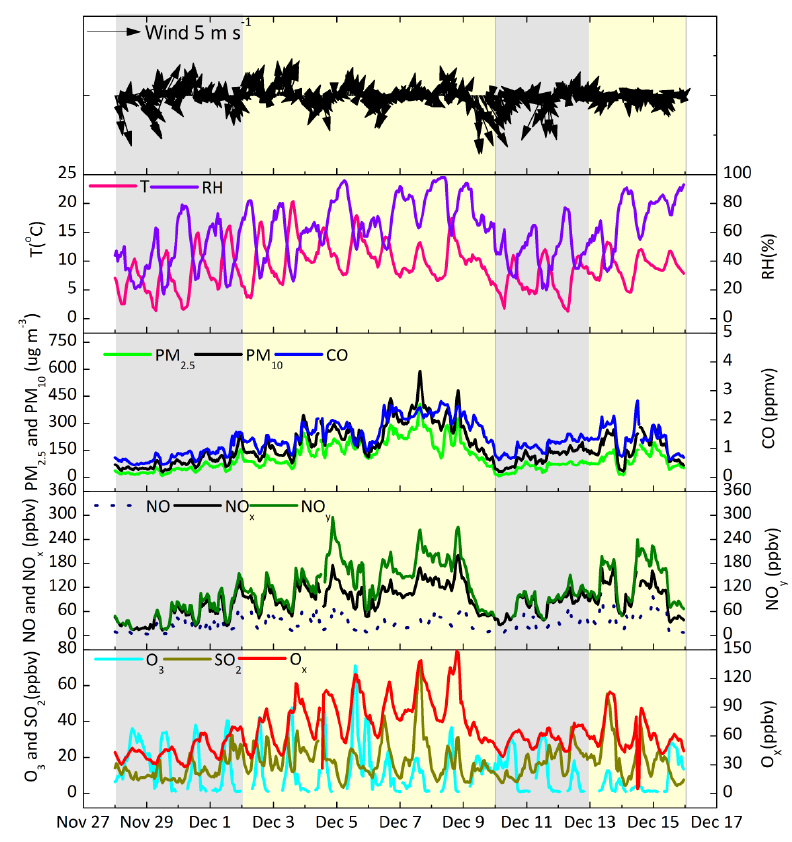
Figure 8. Time series of meteorological parameters and chemical species before, during, and after the haze period. The gray shaded area indicates the Phase I (28 November–1 December) and Phase II (10–12 December), and the yellow shaded area represents haze events Phase III (2–9 December) and Phase IV (13–15